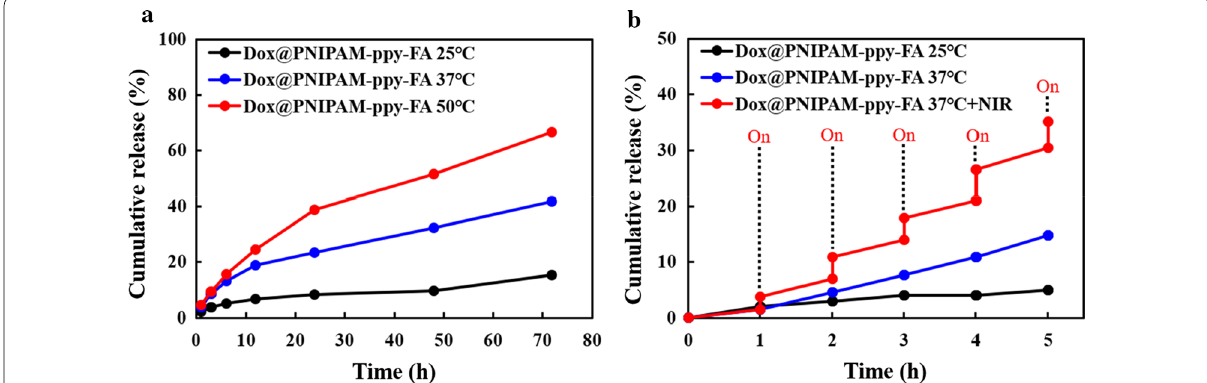
Fig. 4 a Cumulative Dox release profiles of Dox@PNIPAM-ppy-FA via thermo-response and b 808 nm NIR laser